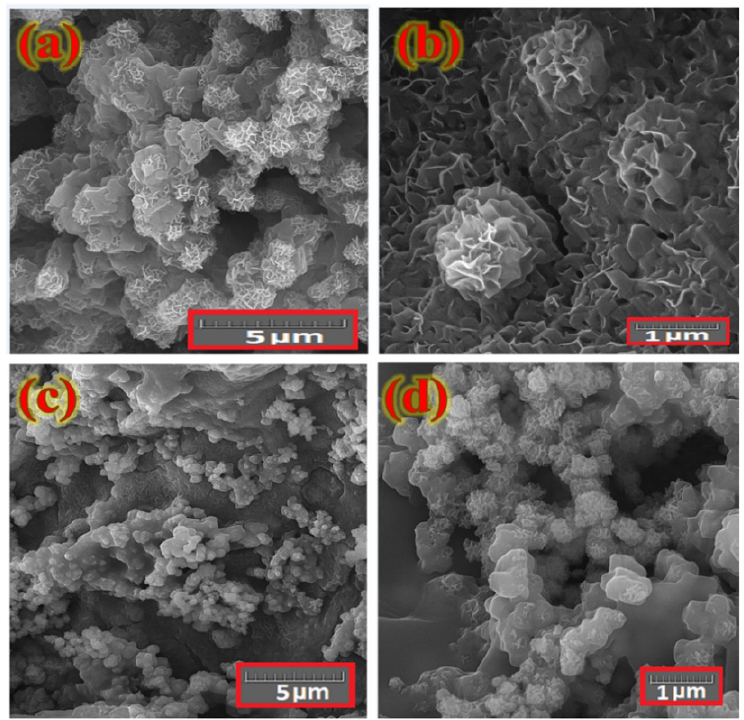
Figure 10. FESEM images of a typical interlaced Co x NiV y O z layer deposited on bare Ni foam ( a , b ), and Ni foam@rGO substrate ( c , d ) after 5500 consecutive charge–discharge cycles at 10 A g − 1.